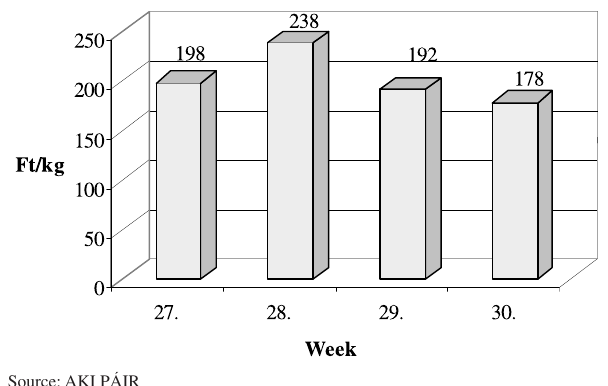
Figure 3: Consumer’s prices of sour cherry for fresh consumption in weekly intervals in the season of 2006